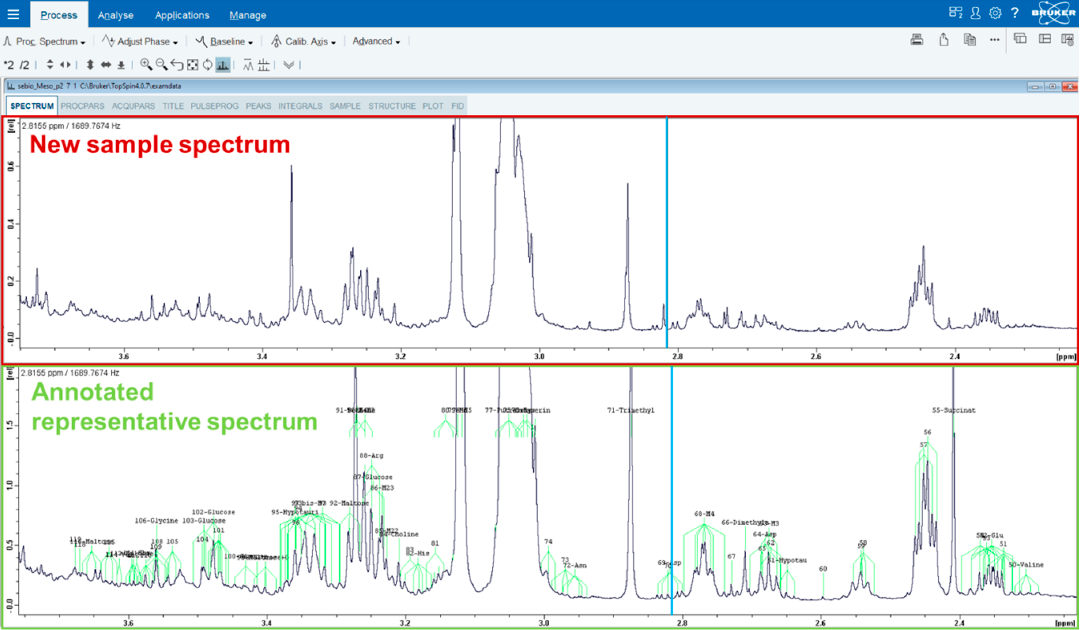
Figure 3. Screen capture exemplifying the comparison of our annotated representative spectrum (green frame) and a new one (red frame) on Topspin 4.0.7. The annotated spectrum (available online on Zenodo, see supplementary materials section) can be zoomed in on a specific region of interest, and the y axis can be adjusted according to the signal intensity in the chosen region. Comparison of the representative spectrum to a new one allows easy signal identification thanks to the cursor (blue line) and global spectra profile visual comparison.